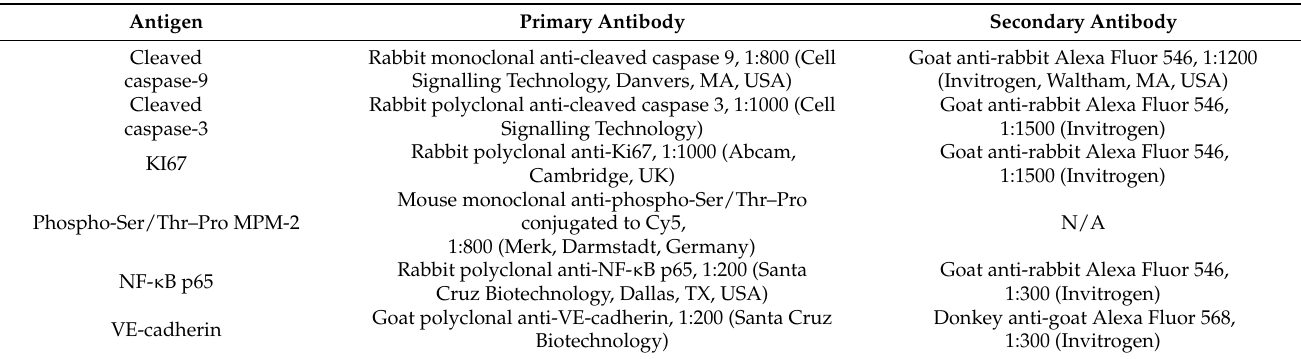
Table 3. List of primary and secondary antibodies used for immunofluorescence staining. Antigen Primary